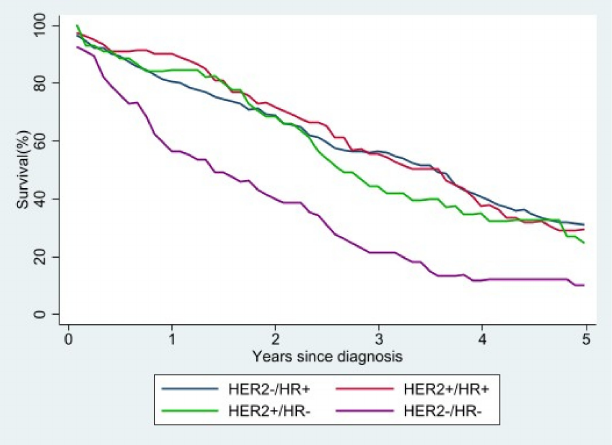
Figure 5. Relative survival of stage IV patients according to molecular subtype.